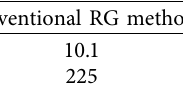
Table 1: Comparisons of modifed and conventional RG algorithm simulation